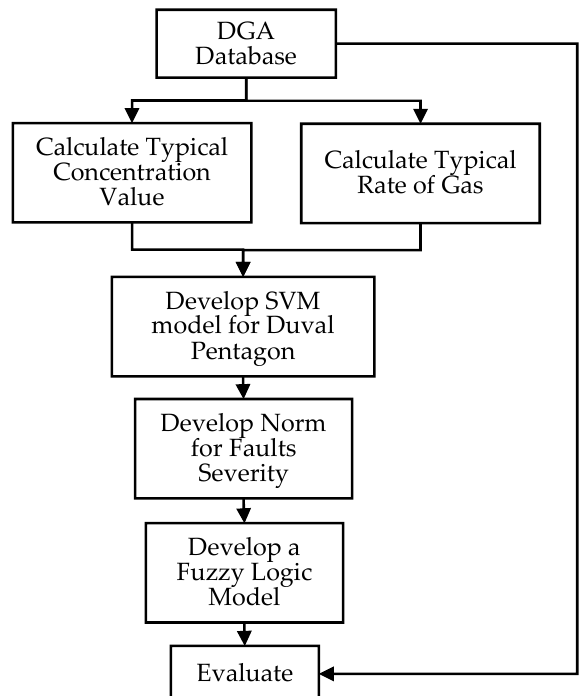
Figure 2. Methodology of the research.